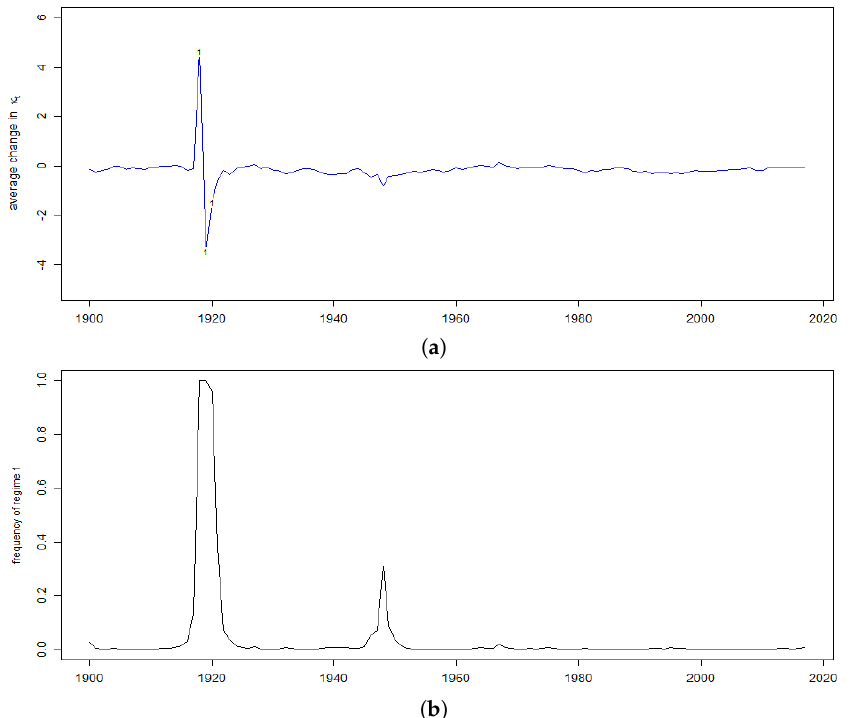
Figure 3. Average change in κ t time varying index over the recorded MCMC runs ( a ) and the average frequency regime 1 ( b ) for Lithuania. Index “1” denotes the periods where the label of regime 1 is assigned in more than 50% of the recorded MCMC runs.